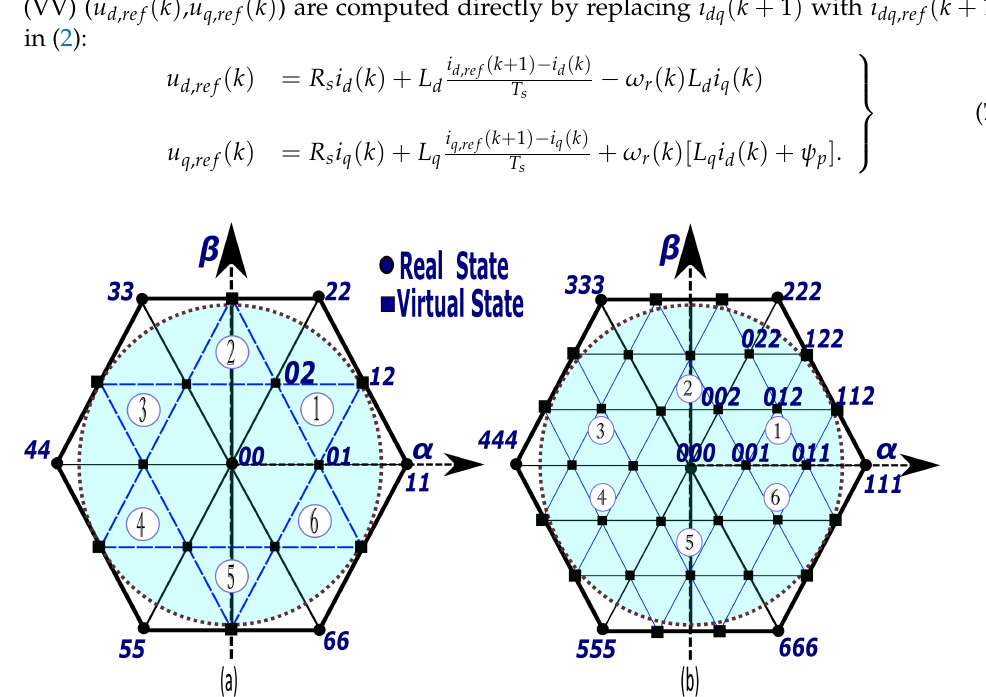
Figure 3. Control region of the two level voltage-source-inverter (2L-VSI) in αβ reference frame with: ( a ) Three additional virtual voltage vectors (VVs)/sector, and ( b ) seven additional virtual voltage vectors /sector.